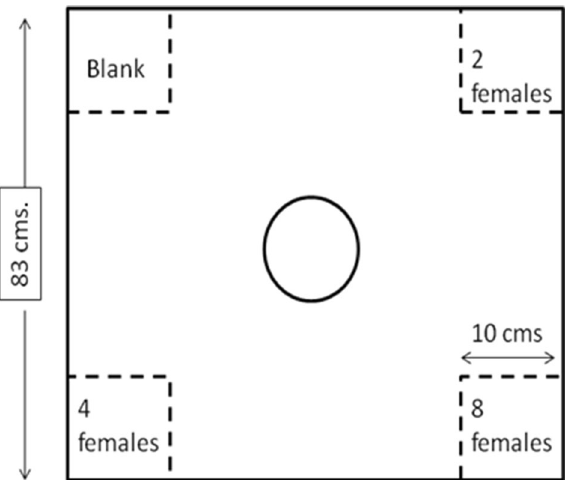
Figure 1. Diagrammatic representation of the arena for the density experimental set-up. The central chamber (indicated by a circle) represents the area where the test males were released and the corner square chamber (separated by transparent mesh) contained females of varying density. The distance of each patch from the central chamber was 40